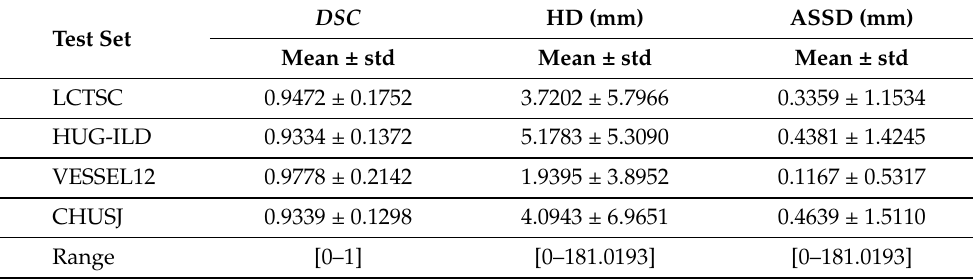
Table 4. Mean and standard deviation (std) results of the three metrics: dice similarity coefficient ( DSC ), Hausdorff distance (HD), and average symmetric surface distance (ASSD) for each dataset. The maximum value of the range for HD and ASSD metrics was obtained by considering that the maximum distance between 2 distinct objects in an image of 128 × 128 corresponded to the diagonal of that